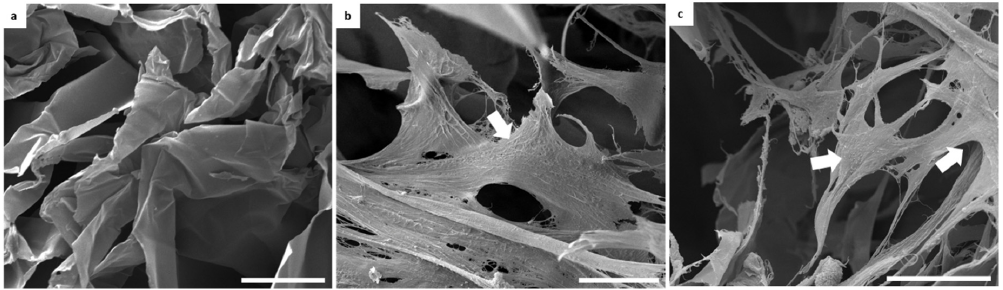
Figure 9. SEM observations of ( a ) the unseeded GCN-25:75 and ( b , c ) the cell-seeded GCN-25:75. Images taken 3 days after seeding. White arrows pointing at cells attached on the biomaterial surface. Scale bar: ( a , b ) 25µm, ( c ) 50µm.